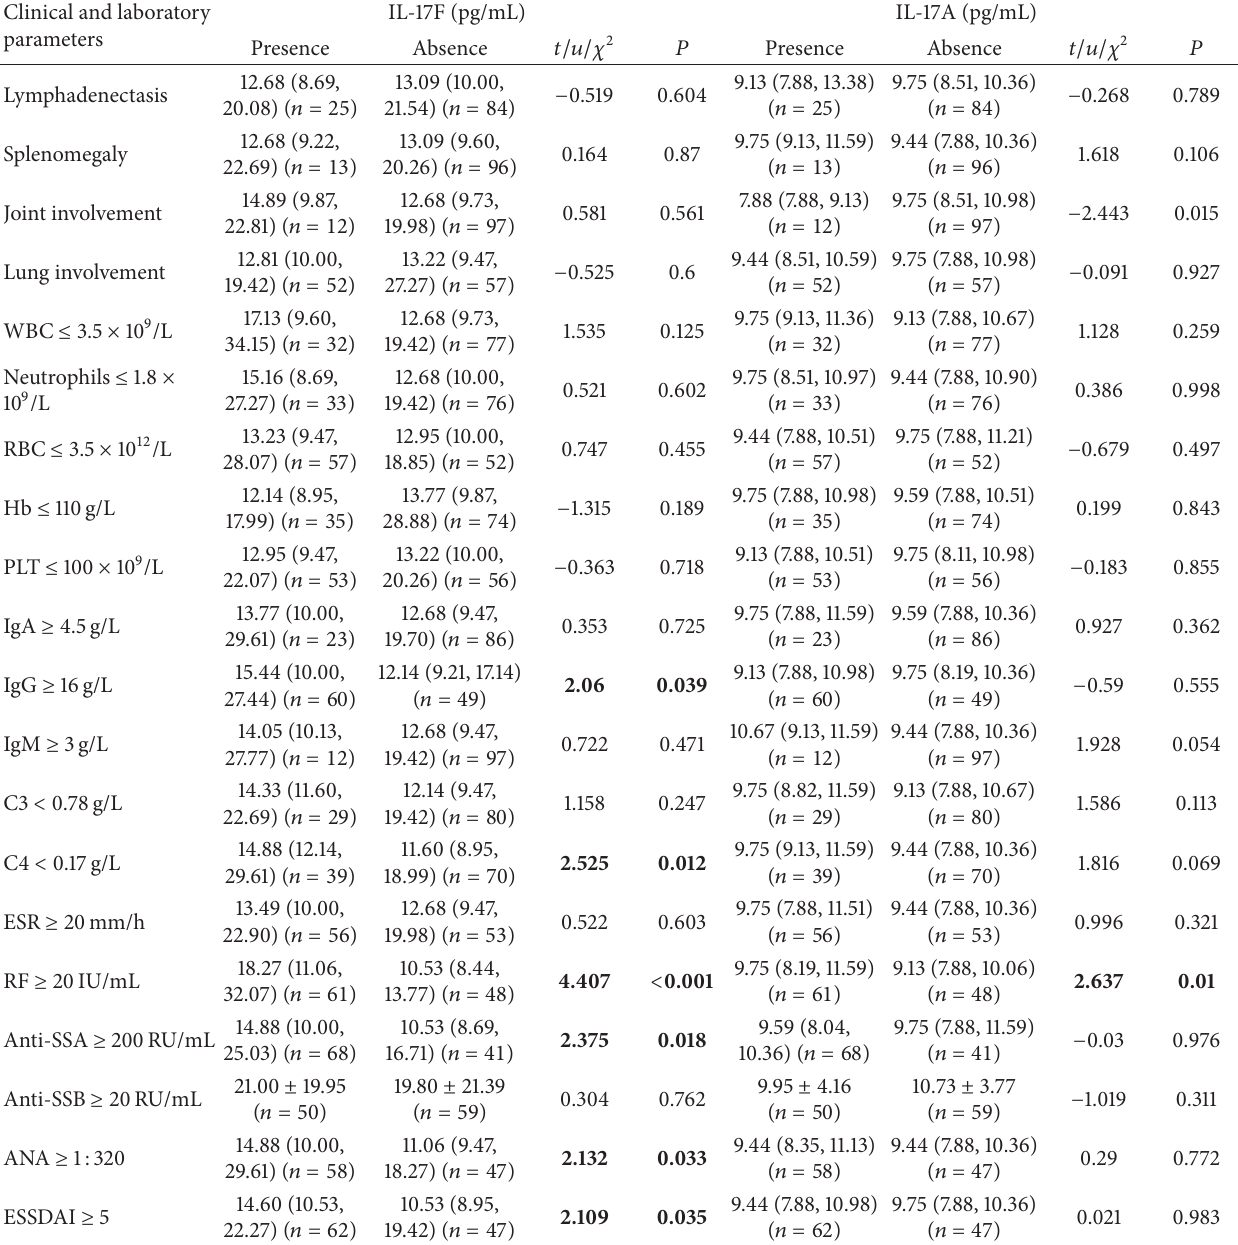
Table 4: Serum levels of IL-17A and IL-17F in the presence and absence of clinical and laboratory manifestations of pSS patients. Clinical and